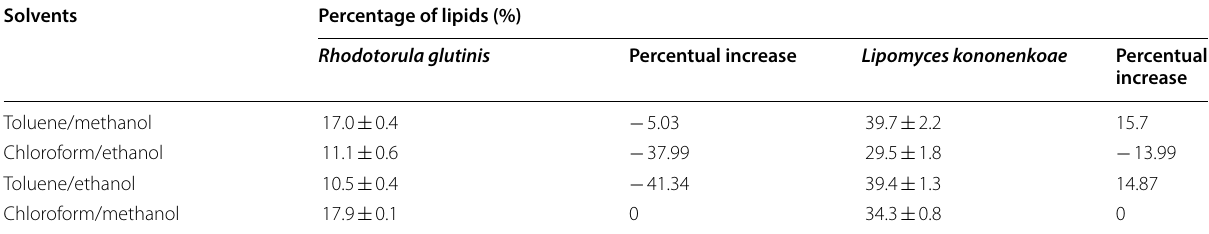
Extractions performed in triplicate